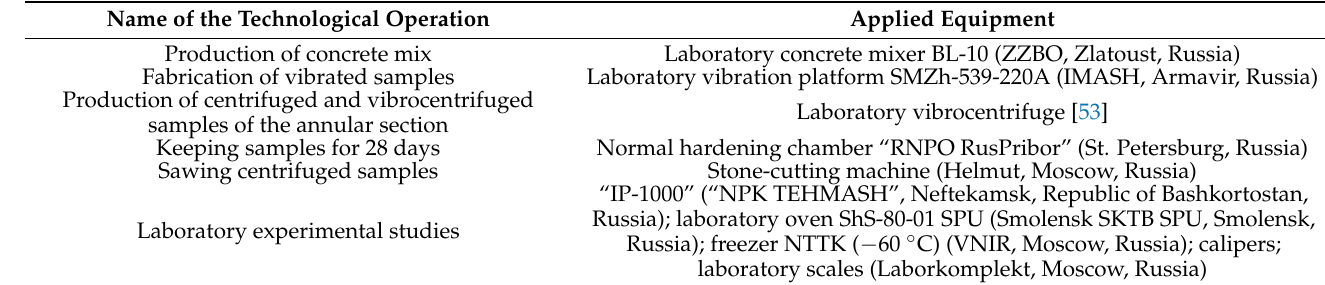
Table 5. List of used laboratory instruments.